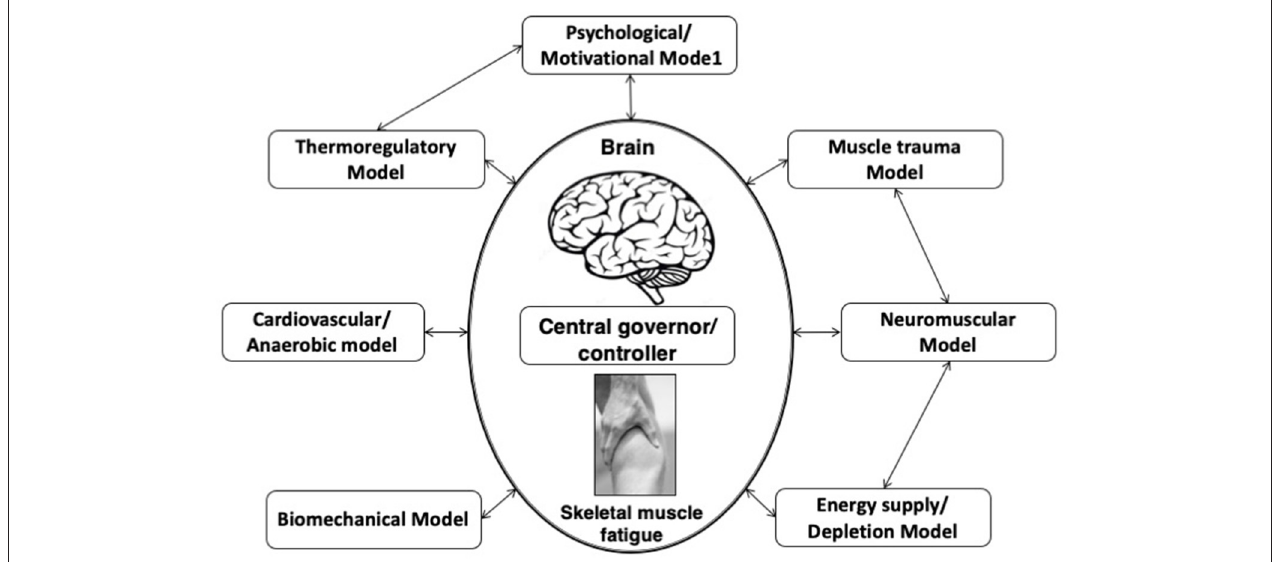
FIGURE 1 | Complex systems model of fatigue. Interaction of developed fatigue models. In this complex systems model of fatigue peripheral feedback originating from numerous linear models of fatigue are integrated by the brain, along with centrally located senses.